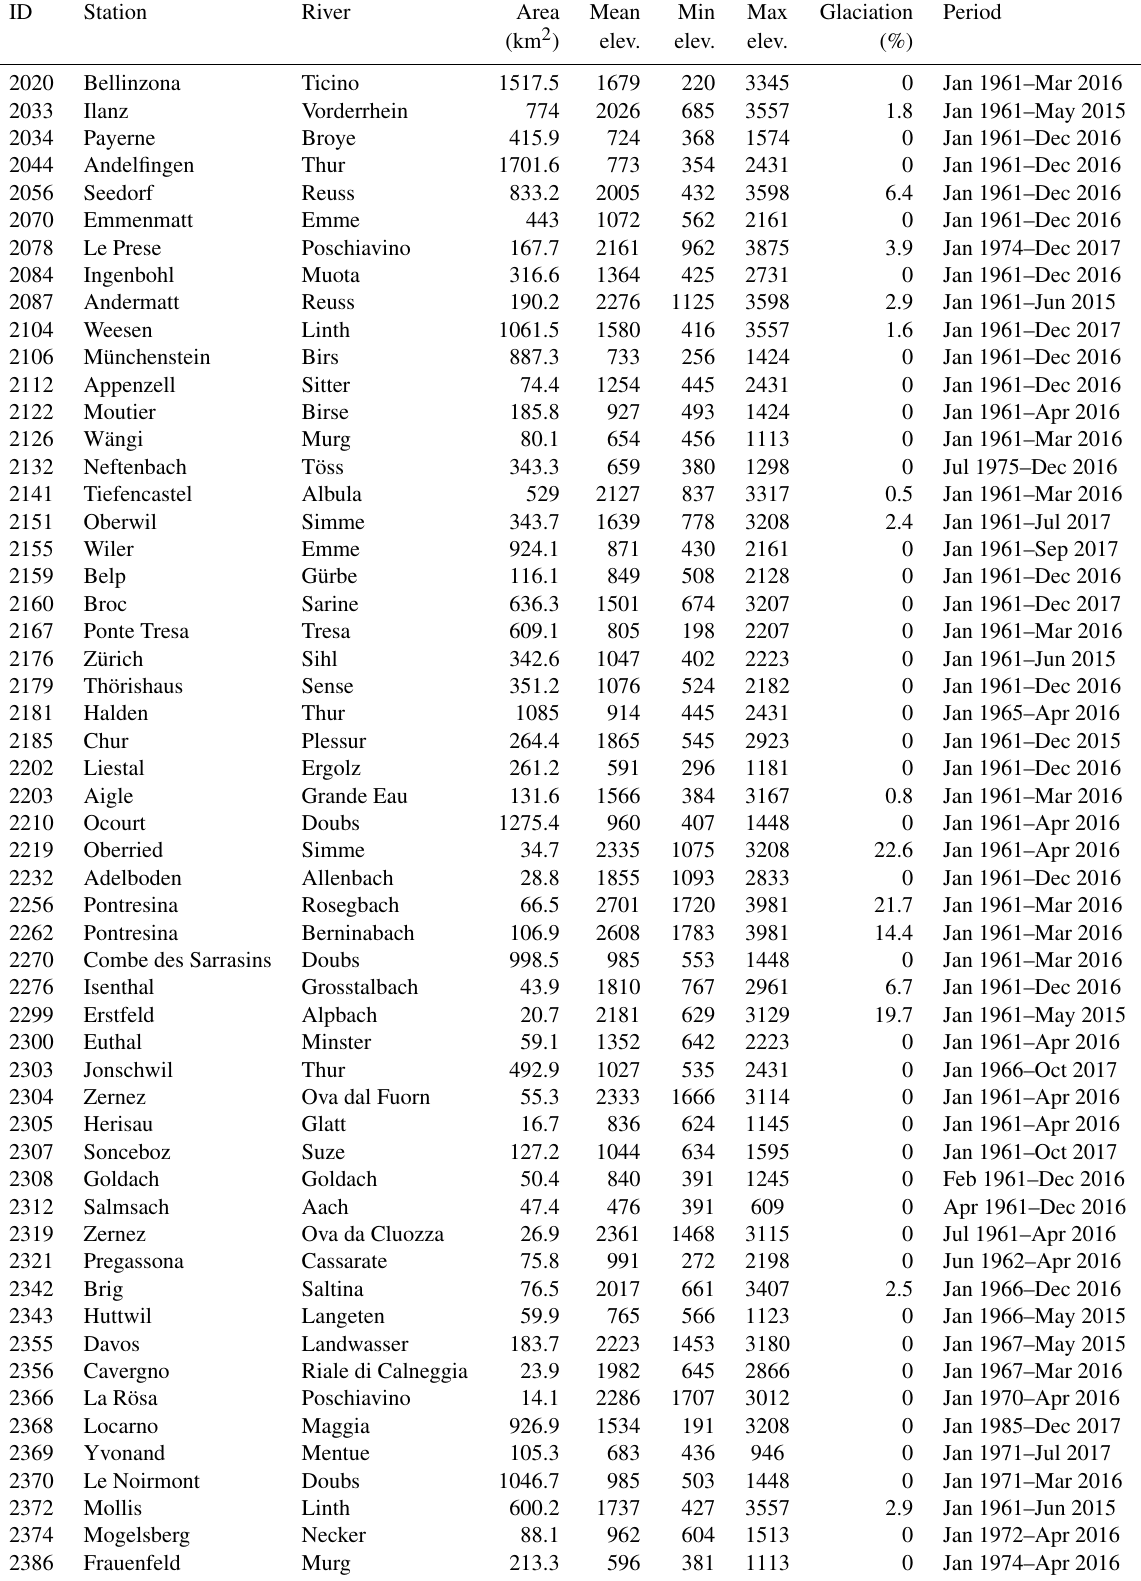
Table A1. List and main characteristics of the 93 gauged Swiss catchments used in this study.